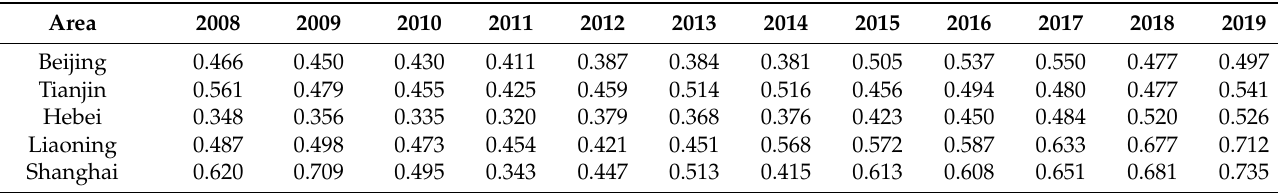
Table 3. Population aging index of provinces and municipalities from 2008 to